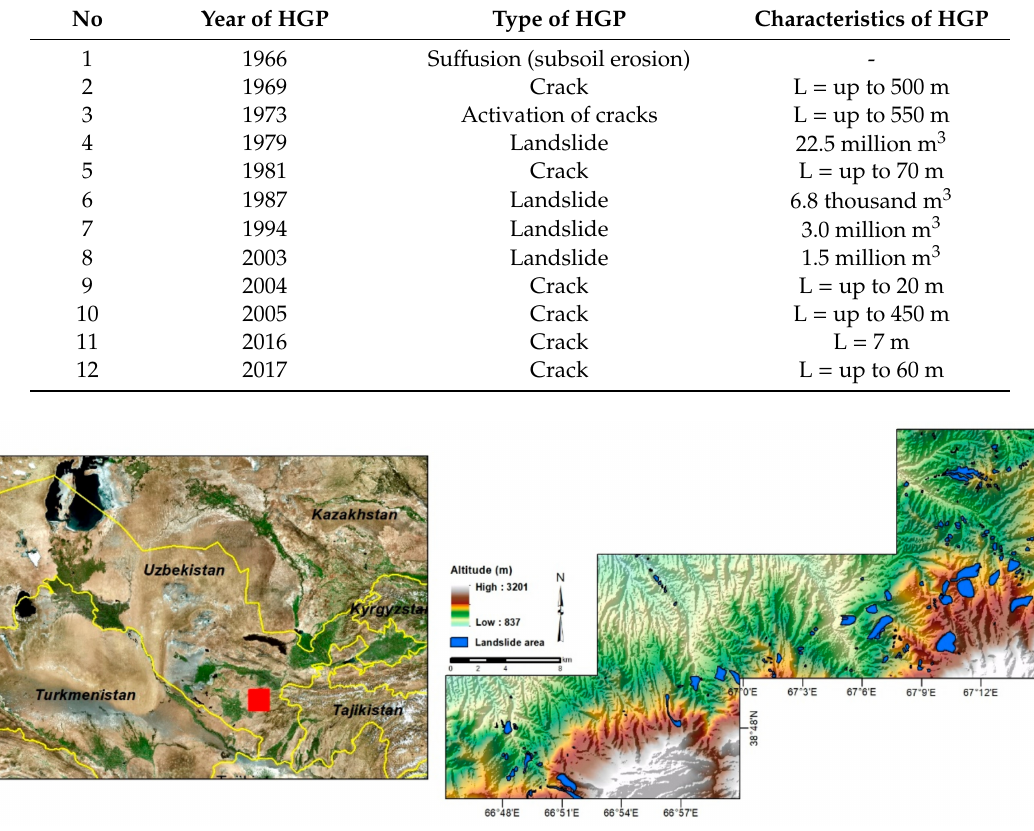
Figure 2. Location of study area ( left ) and historical landslide locations ( right